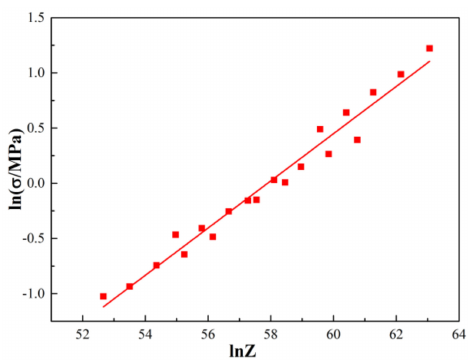
Figure 7. The relationship between ln [ sinh [ ασ ]] and